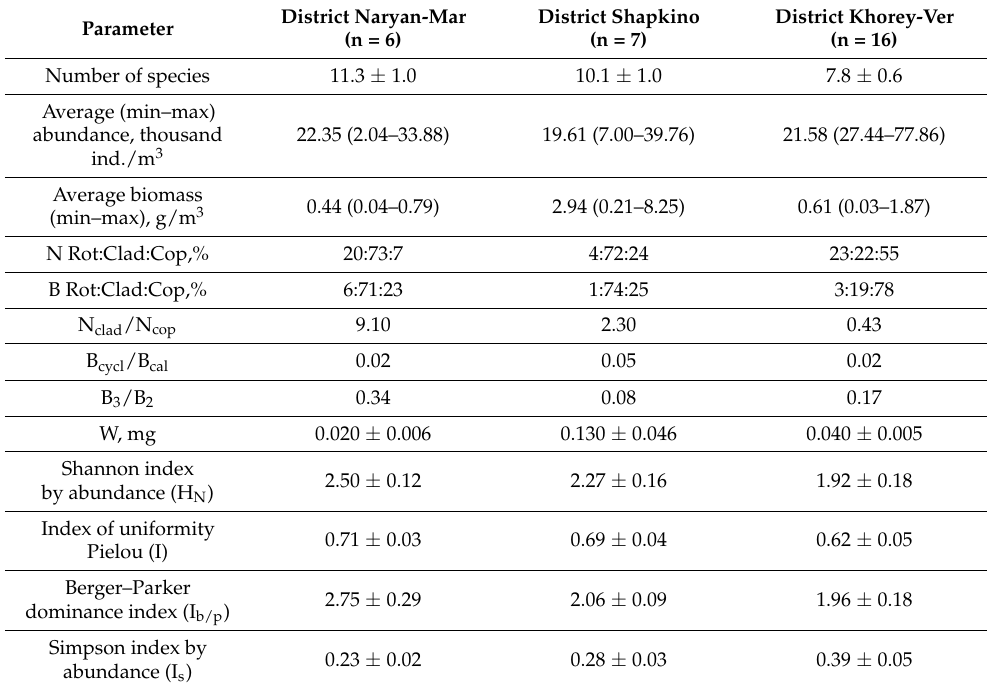
Table 2. General characteristics of zooplankton communities of thermokarst reservoirs in three study